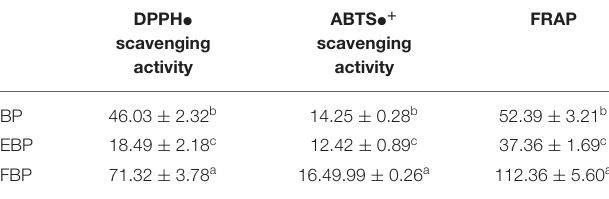
TABLE 9 | Antioxidant activity of BP, EBP, and FBP